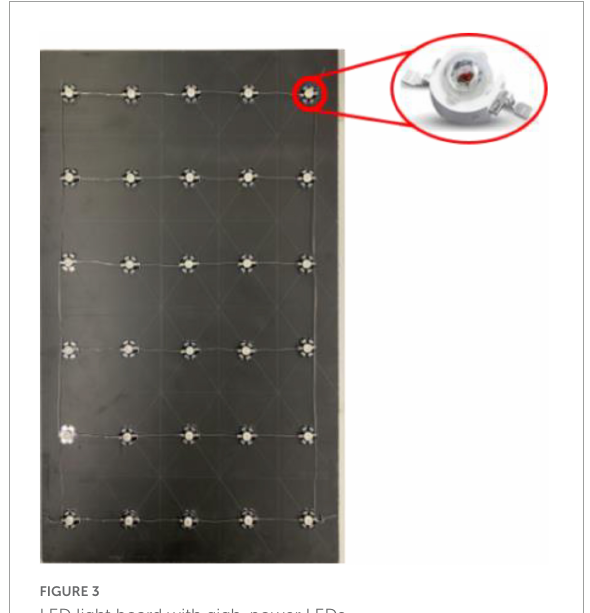
FIGURE3 LED light board with gigh-power